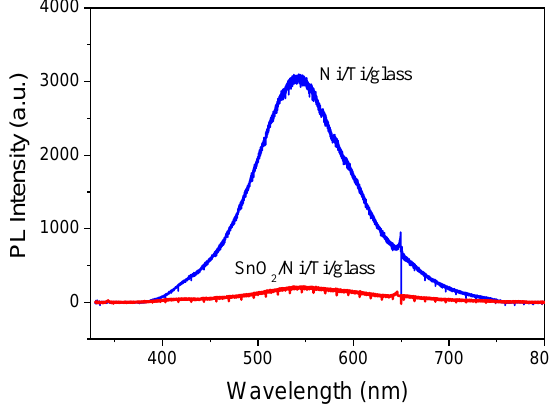
Figure 9. Photoluminescence spectra of TiO 2 films on Ni/Ti coated glass and on SnO 2 /Ni/Ti coated glass under 325 nm excitation.